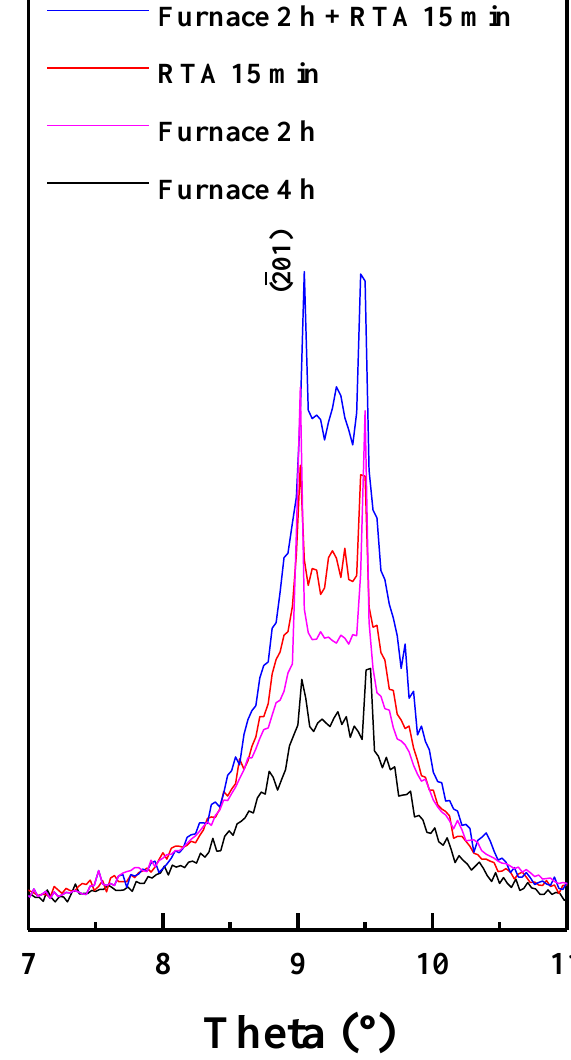
Figure 4. X-ray rocking curve of the super lattice for ( − 201) reflection in various annealing pro-